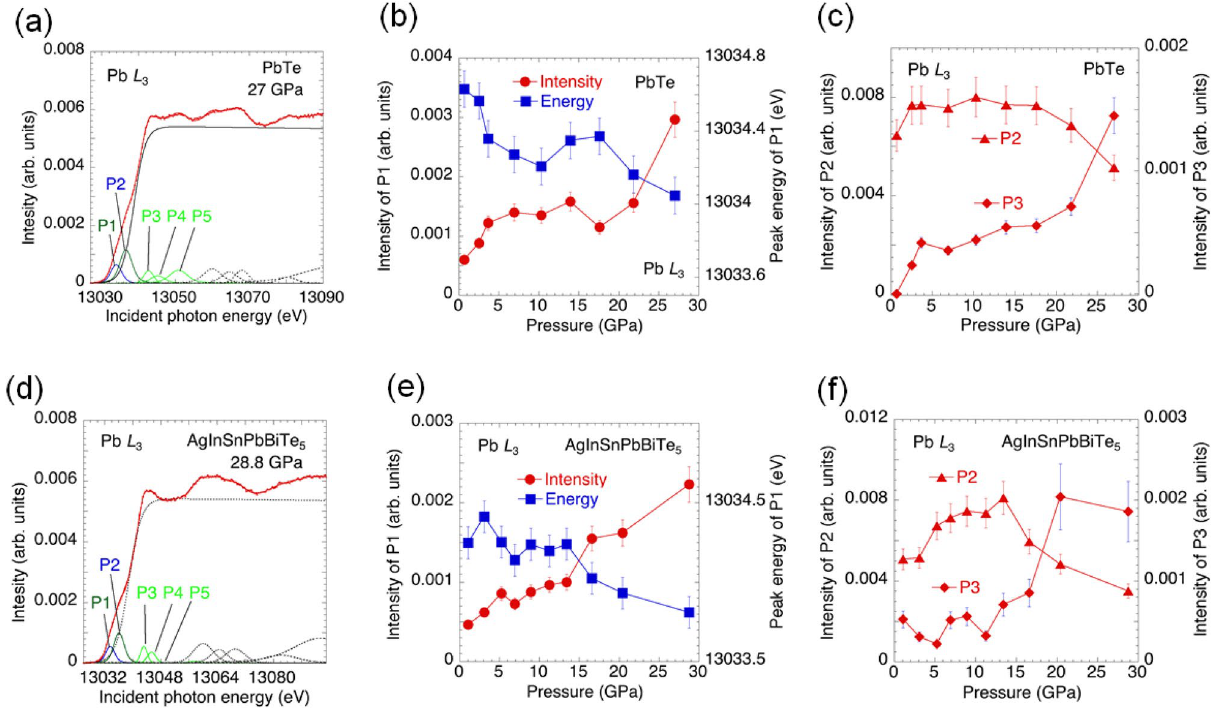
Figure 4. Electronic structure of PbTe and AgInSnPbBiTe 5 under high pressure. ( a ) Typical Pb- L 3 PFY-XAS spectrum and an example of the fit to the spectrum for PbTe at 27 GPa. ( b ) Pressure dependence of the intensity and the energy of the peak P1 for PbTe. ( c ) Pressure dependence of the intensity of the peaks P2 and P3 for PbTe. ( d ) Typical Pb- L 3 PFY-XAS spectrum and an example of the fit to the spectrum for AgInSnPbBiTe 5 at 28.8 GPa. ( e ) Pressure dependence of the intensity and the energy of the peak P1 for AgInSnPbBiTe 5 . ( f ) Pressure dependence of the intensity of the peaks P2 and P3 for AgInSnPbBiTe 5